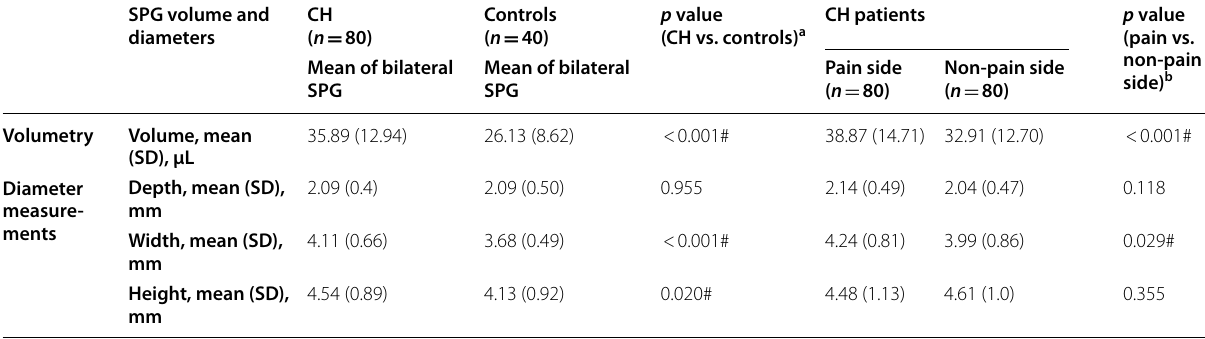
Table 2 Comparisons of SPG volume and diameters (CH patients vs. non‑headache healthy controls and pain side vs. non‑pain side)